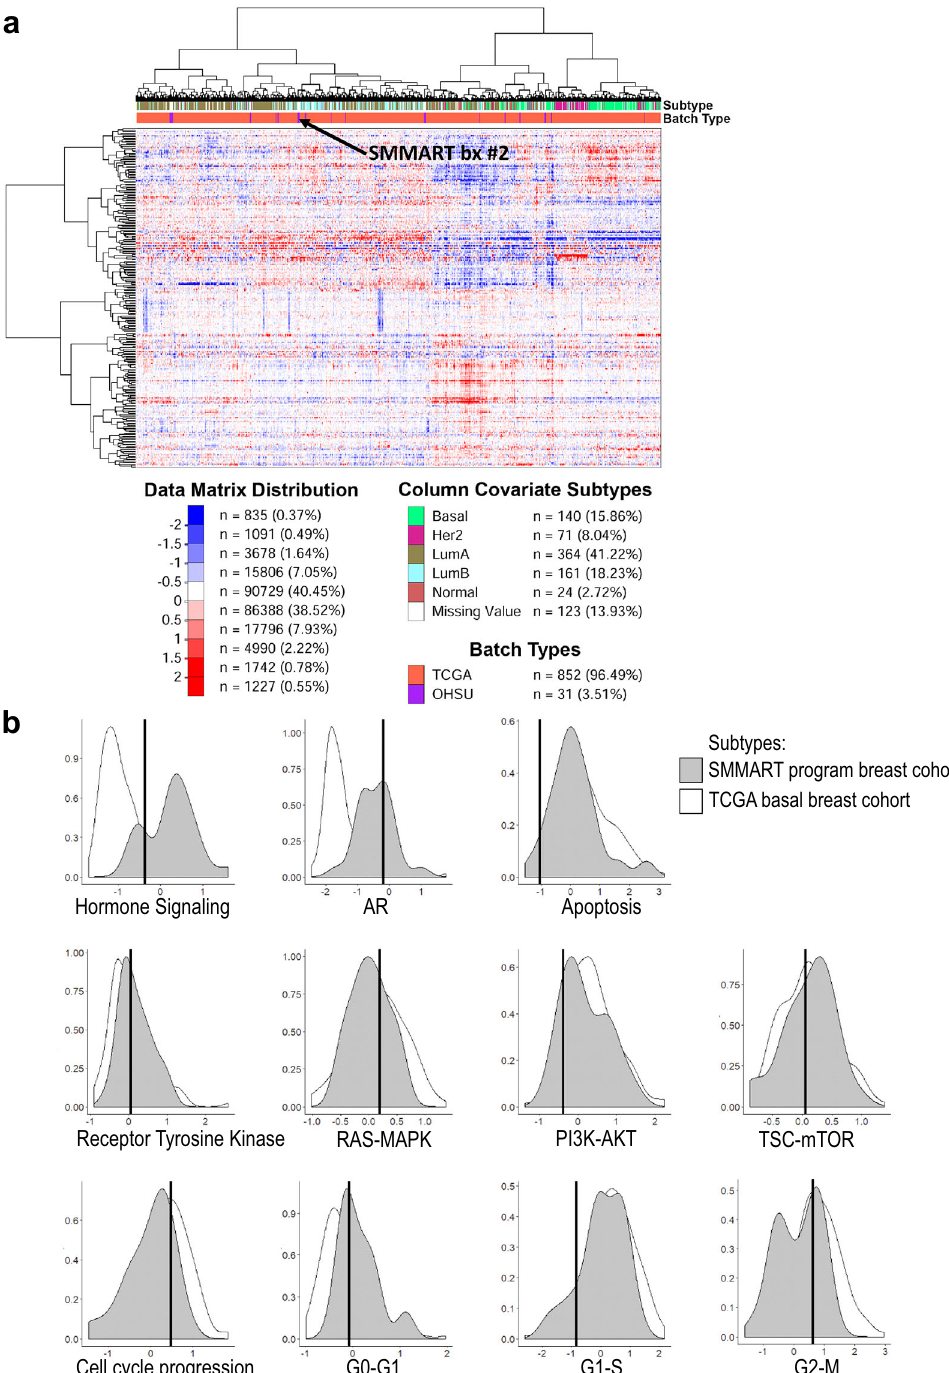
Fig. 5 Reverse Phase Protein Array (RPPA) pro fi ling by subtype clustering and pathway analysis of proteins and phosphoproteins in Study biopsy #2. Protein expression values were normalized within the TCGA breast cancer cohort. a The heat map represents a rank sum ordering of the protein expression across TCGA (red), 31 SMMART-program samples (purple), and Study biopsy #2 (arrow). The red and blue colors represent higher and lower expression proteins, respectively. b Pathway pro fi ling by RPPA. The data were z -scored and pathway activity was assessed using pathway scores calculated as described previously 56 . The histogram represents the distribution of the pathway ’ s activity ( Y -axis = density) of the TCGA basal breast cancer cohort (white) and SMMART-program cohort (gray) as well as the pathway activity of Study biopsy #2 (black line). See Supplementary Table 1 for proteins comprising each RPPA